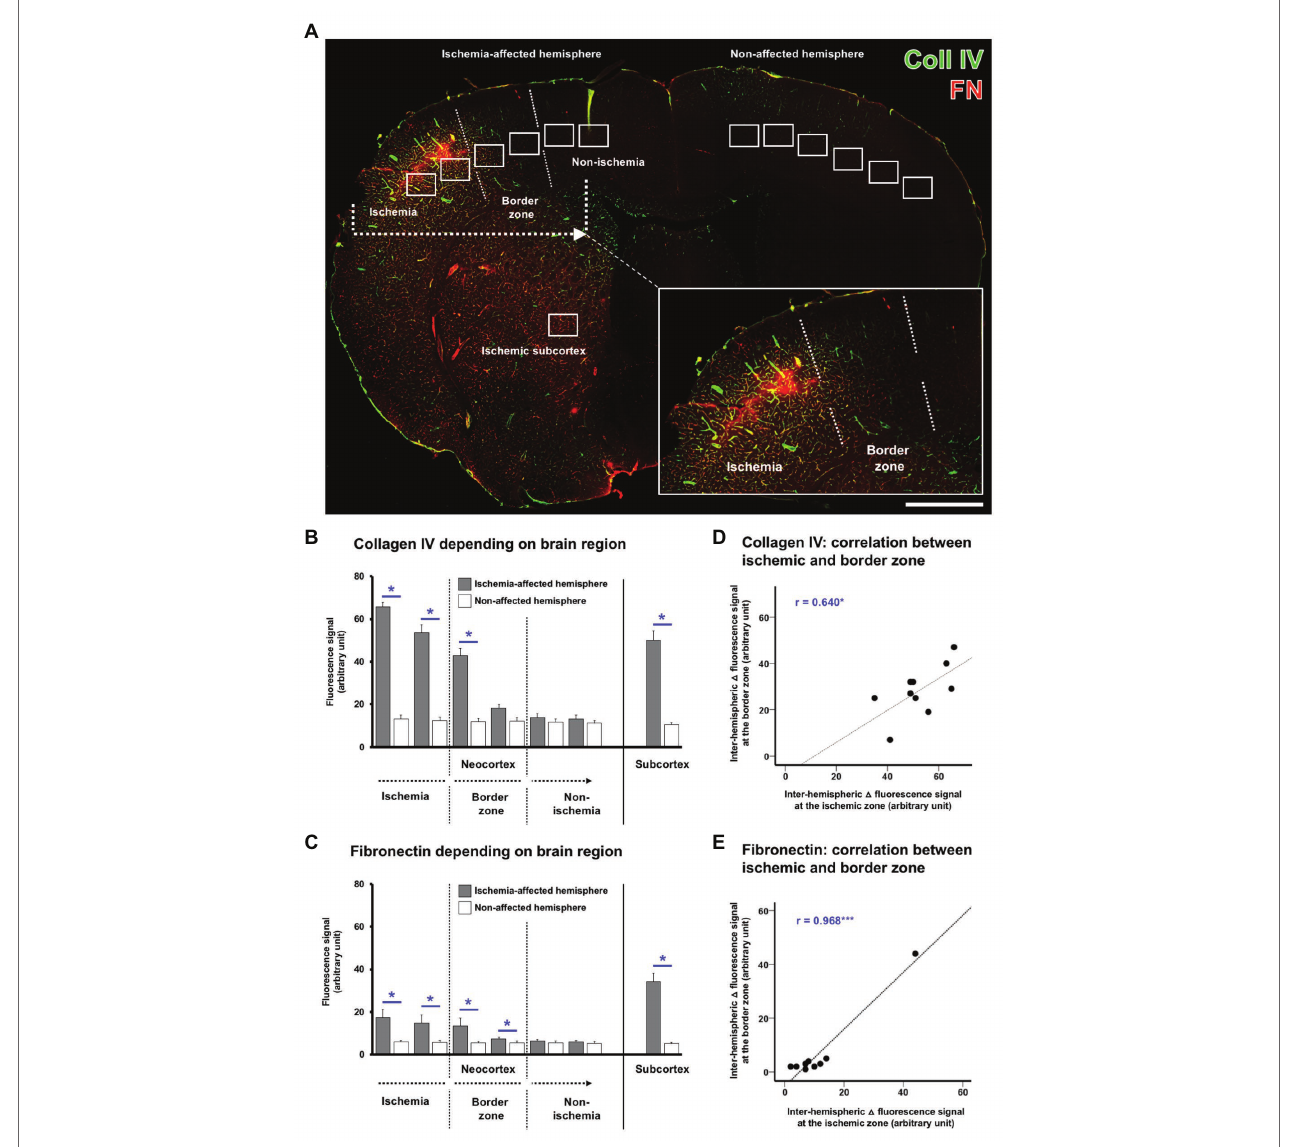
FIGURE 3 | Quantification of collagen IV and fibronectin immunosignals in the overall sample of mice subjected to 4 or 24 h of experimental focal cerebral ischemia. Region-related quantification of both immunosignals based on seven regions of interest (ROIs) located on the ischemia-affected hemisphere, while seven ROIs mirrored to the contralateral, i.e., non-affected hemisphere served as control (A) . The ischemia-affected neocortex is captured by six ROIs with the ischemic border zone in the middle part, and the subcortical region is captured by a single ROI (A) . Immunosignals of collagen IV (B) and fibronectin (C) are significantly increased in the neocortical area of maximum ischemic affection with a gradual decline toward the ischemic border zone and the non-affected region. A significantly increased immunosignal is also seen in the subcortical region (B,C) . Correlation plots including the area of maximum ischemic affection and the ischemic border zone indicate a strong positive correlation between these regions for the inter-hemispheric differences of collagen IV (D) and fibronectin (E) indicating commutated changes in both regions at the same time. Scale bar: in A = 1 mm. Bars represent means and added lines represent the standard error of means. r : Pearson correlation coefficient. Levels of statistical significance: * p < 0.05, *** p <